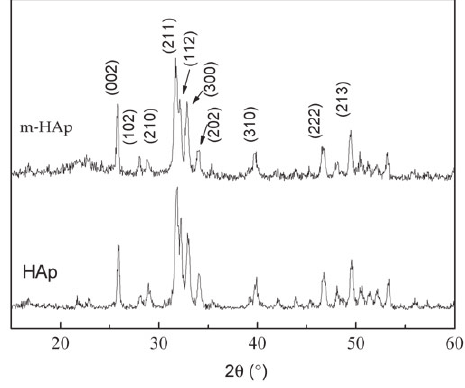
Figure 2 XRD spectra of HAp and